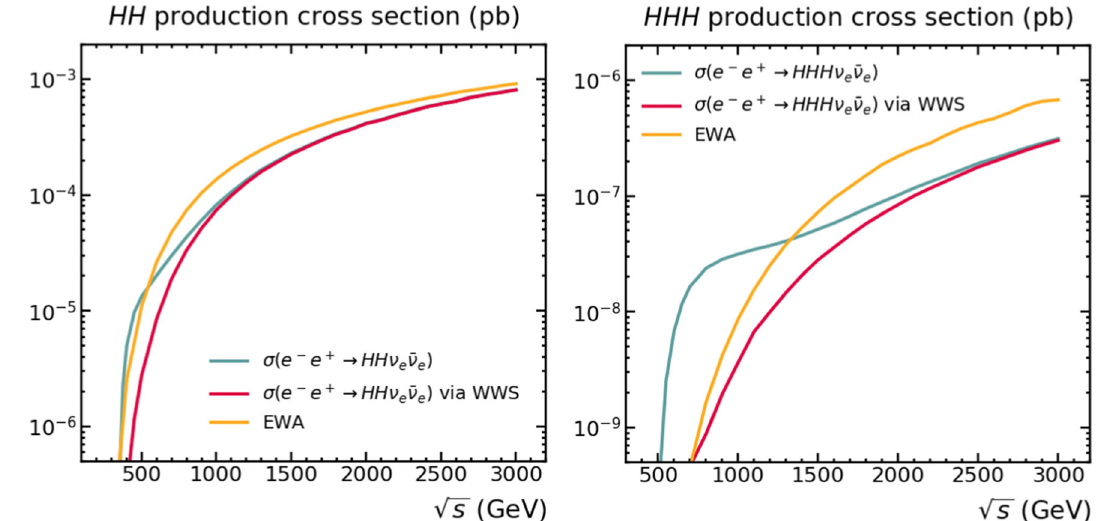
Fig. 6 MG5 and EWA predictions of the cross sections σ( e + e − → H H ( H )ν e ¯ ν e ) as a function of energy for double Higgs (left panel) and triple Higgs (right panel) production. The predictions for σ( e + e − → H H ( H )ν e ¯ ν e ) via WWS as defined in Eq. (7) are also included